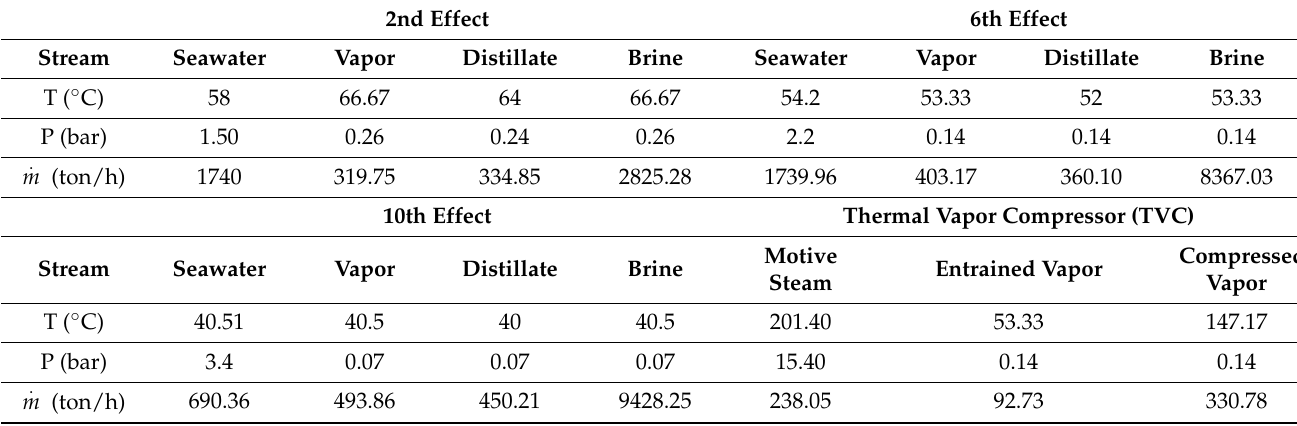
Table 4. Selected streams results obtained from MED-TVC simulation flowsheet.